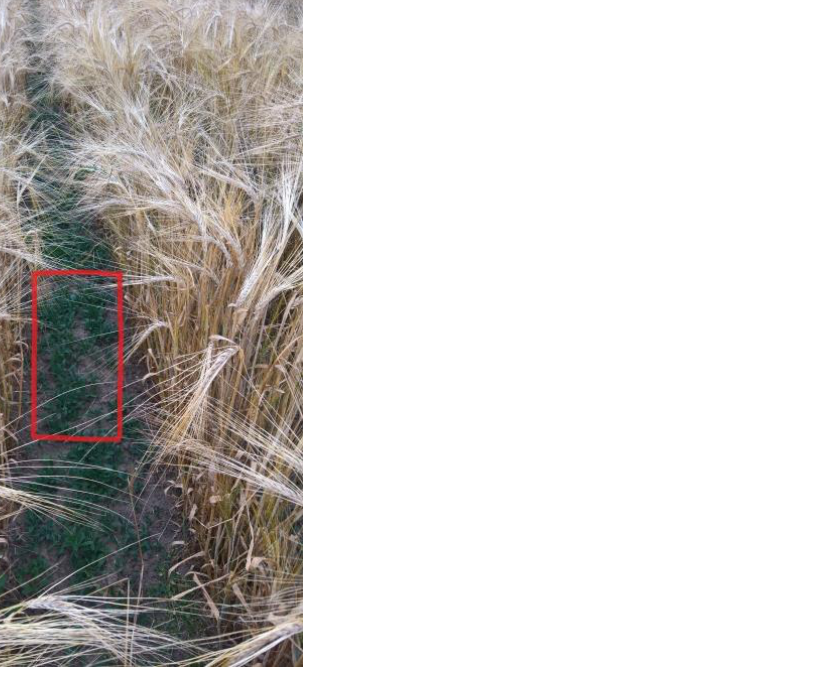
Figure 3. L. squarrosa plantlets (red box) between rows of the follow-up crop H. vulgare , originating from hibernated seeds of L. squarrosa growing on this plot two years ago (Plot C). These plants originated from twice hibernated L. squarrosa seeds, which were still As shown in Table 6, roots and straw of most of these crop plants next to the L. present in the soil from the L. squarrosa cultivation two seasons ago and which were still